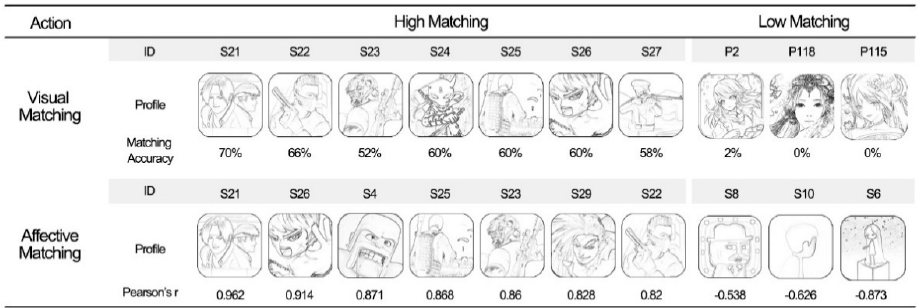
Figure 7. Action game icons with high perceptual matching.